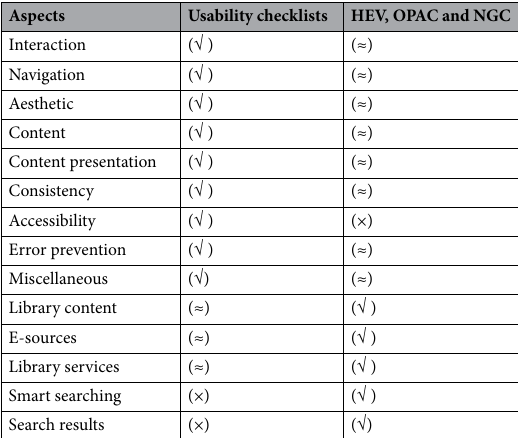
Table 1. Literature analysis: (where (√) shows that the particular aspect exists in the given literature (shows > = 50 < = 100% presence in literature), (×) represents that the particular aspect does not exist or 0%referred to by the particular literature and the symbol (≈) represents that the particular usability aspect is referred > 0 < 50% in the given literature).